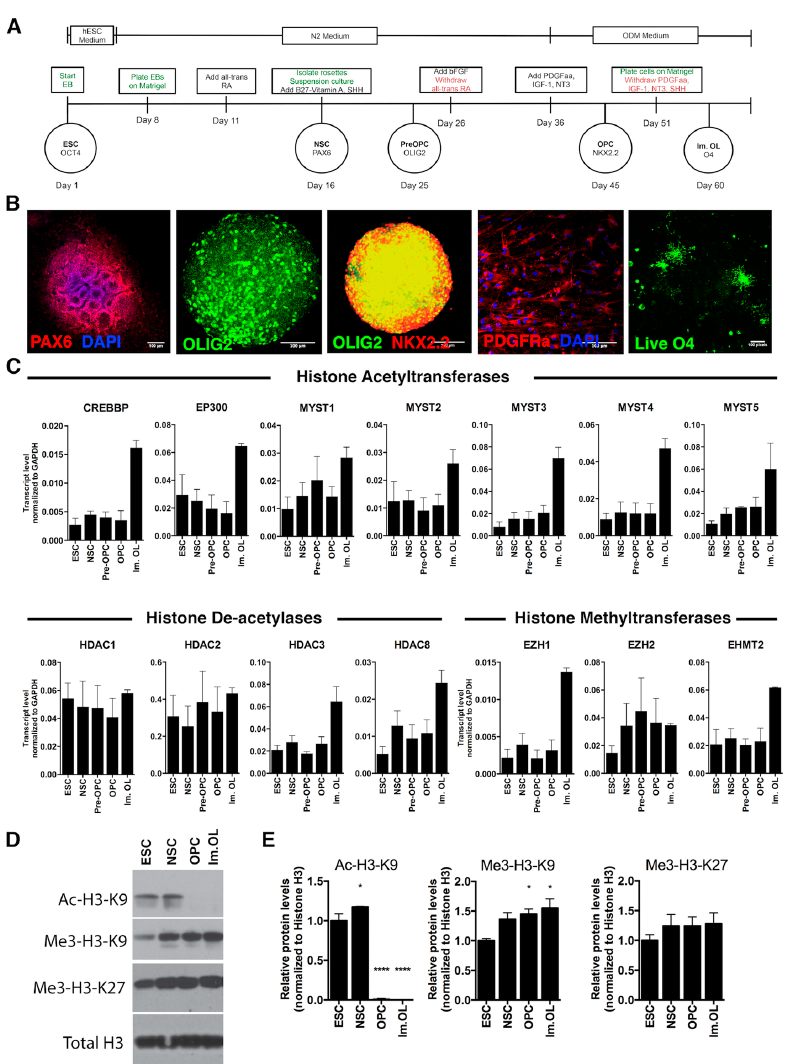
Figure 1. Expression pattern of histone modifiers and relative histone marks during oligodendrocyte differentiation of ESCs. ( A ) Diagram depicting the major steps of oligodendrocyte differentiation with the corresponding cellular markers that peak at different days of differentiation. In green are described the technical procedures and in red the reagent withdrawal. ESC: embryonic stem cell; EB: embryoid body; NSC: neural stem cell; OPC: oligodendrocyte progenitor cell; Im. OL: immature oligodendrocyte; ( B ) Representative images showing immunofluorescent detection of oligodendrocyte-lineage markers during differentiation. From left to right : PAX6 in rosette-like structures, OLIG2 in free-floating spheroids, coexpression of OLIG2 and NKX2.2 in free-floating spheroids, PDGFR α in single cells after trituration of spheroids, live O4 staining in single cells; scale bars: 100 µm; ( C ) Transcriptional levels of histone acetyltransferases, deacetylases and methyltransferases during oligodendrocyte differentiation. The bars are the mean ± SEM relative to GAPDH; ( D ) Western blot analysis of specific epigenetic marks on H3 at different days of differentiation; ( E ) Quantification of Western blots was performed by determining the relative expression level of (from left to right) Ac-H3-K9, Me3-H9-K9 and Me3-H9-K27 relative to histone H3. Data were normalized to ESC, and results are expressed as the mean ± SEM (* p < 0.05; **** p < 0.0001).